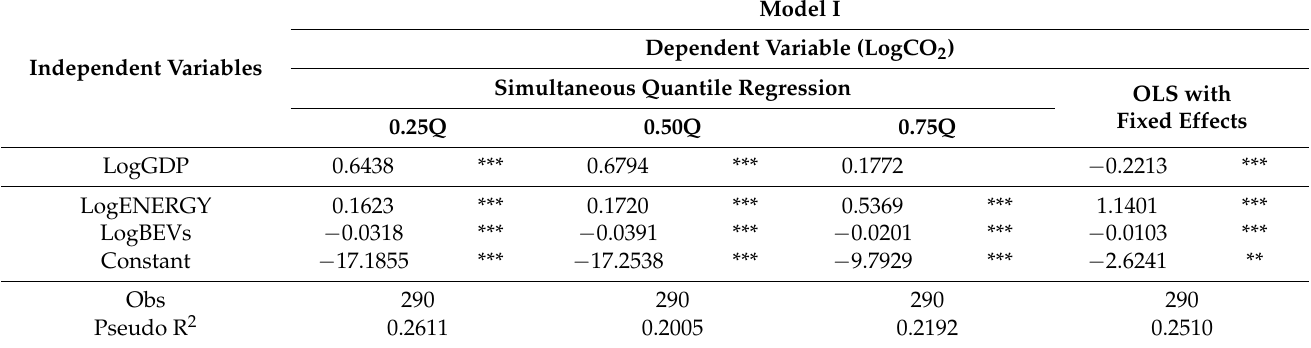
Table 10. Estimation results from simultaneous quantile regression and OLS with fixed